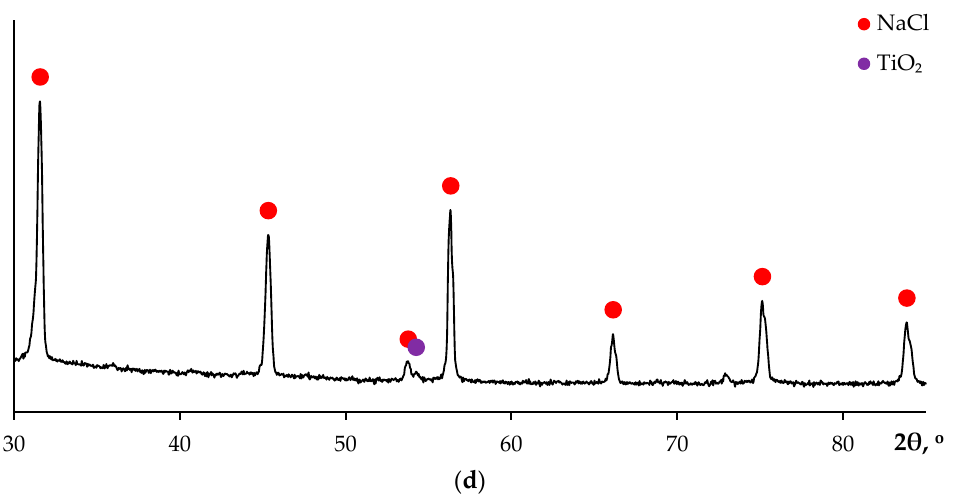
Figure 11. Results of XRD analysis of the salt contaminations on the surfaces of coarse-grained ( a , b ) and UFG ( c , d ) specimens after HSC testing: ( a , c ) V h = 50 °C/min, T = 600 °C, t = 10 min, P = 50 MPa; ( b ) V h = 50 °C/min, T = 1030 °C, t = 10 min, P = 50 MPa; ( d ) V h = 50 °C/min, T = 1140 °C, t = 10 min, P = 50 MPa.